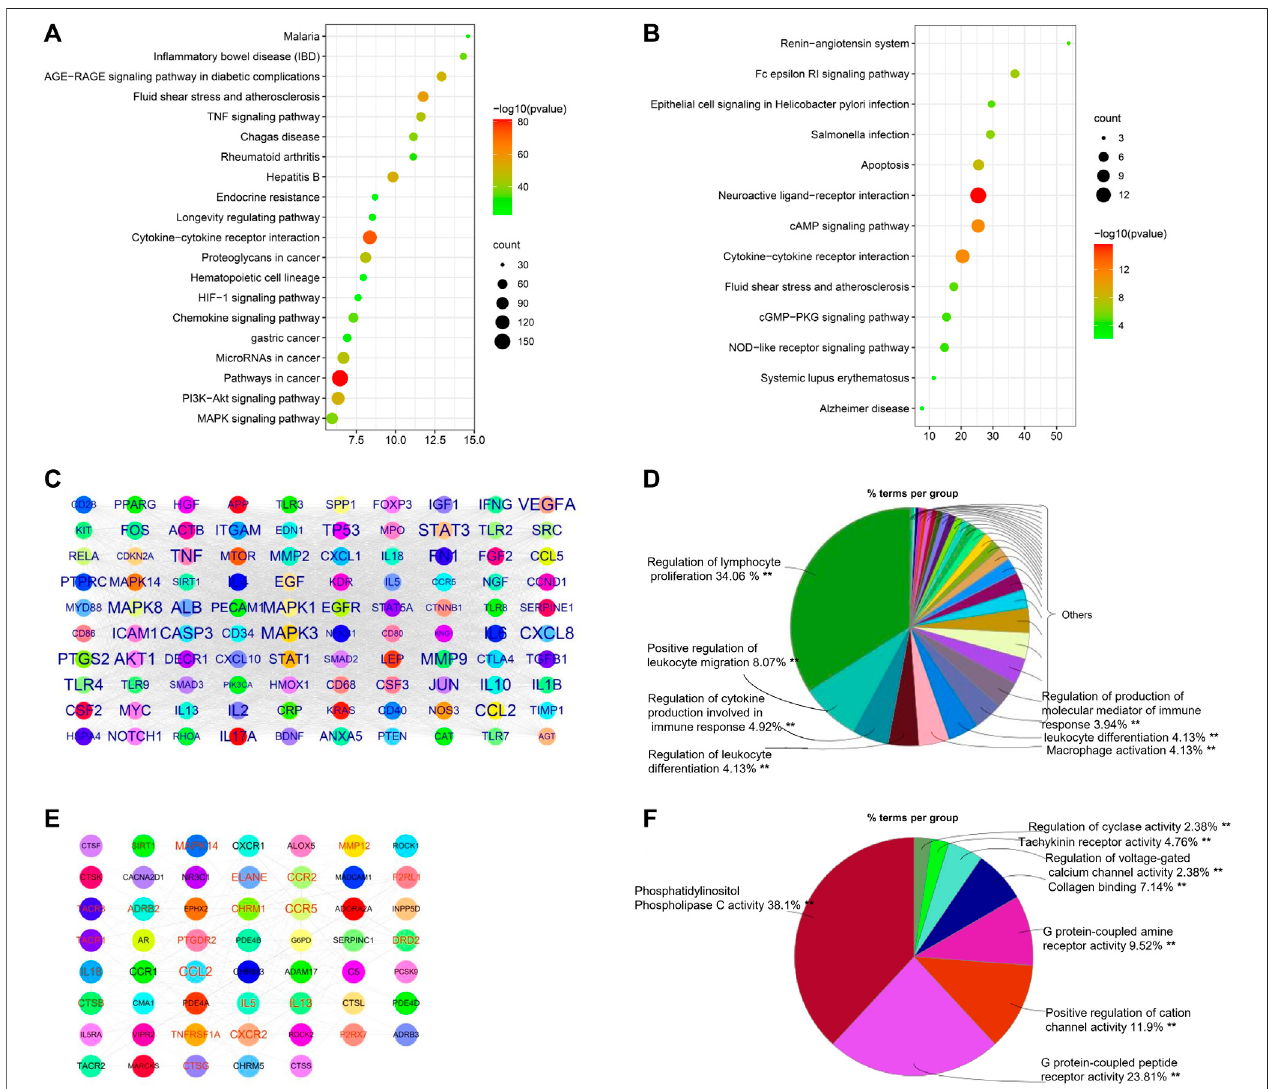
FIGURE 3 | Bioinformatics analysis of COPD genes and targets. (A) Top 20 enriched KEGG pathways of COPD genes and (B) COPD targets, constructed using Metascape. (C) Protein – protein network of top 100 COPD genes constructed by Cytoscape. The size of the label is proportional to its strength. (D) Immune system process analysis of the top 100 COPD genes using ClueGo in Cytoscape. The size of the label is proportional to its strength. (E) Protein – protein network of COPD targets. (F) Immune system process analysis of COPD targets.